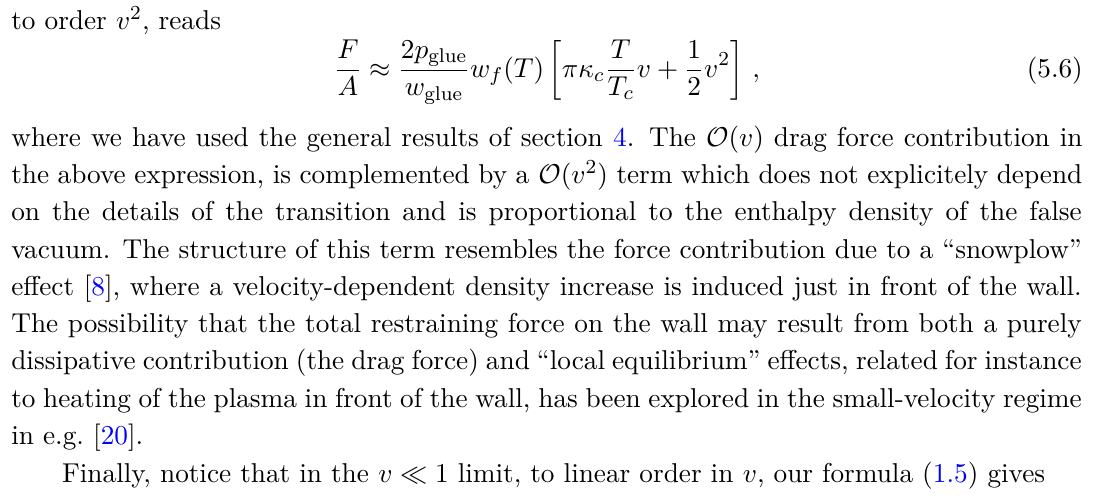
Figure 6 . Bubble velocity as a function of the relative temperature T/T c in the WSS model. The solid line is the result of this paper, formula (1.5) with C Chapman-Jouguet formula (5.3) with parameters λ = 100 , N = 100 , N f χ is given in (2.15) (this choice corresponds to a v CJ close to the other results for large v ). The short-dashed (orange) and dot-dashed lines correspond to the linear and quadratic γ -dependences as in (5.1). The long-dashed (violet) curve corresponds to formula